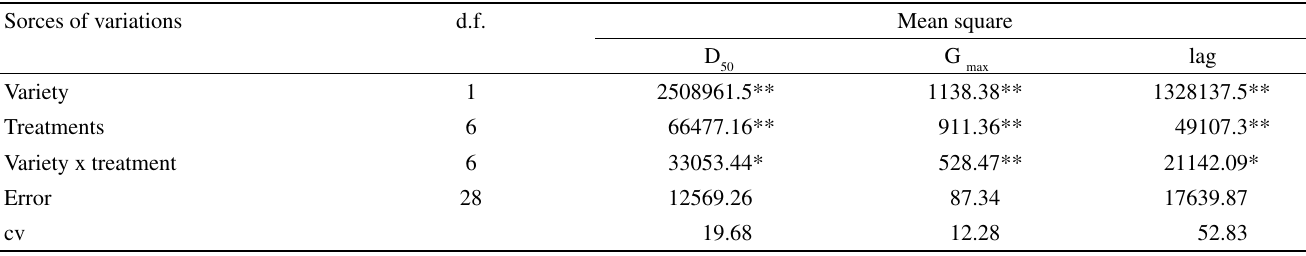
Table 1 - The results of analysis of variance of the effects of chemical treatments on dormancy removal and germination parameters of two cultivated